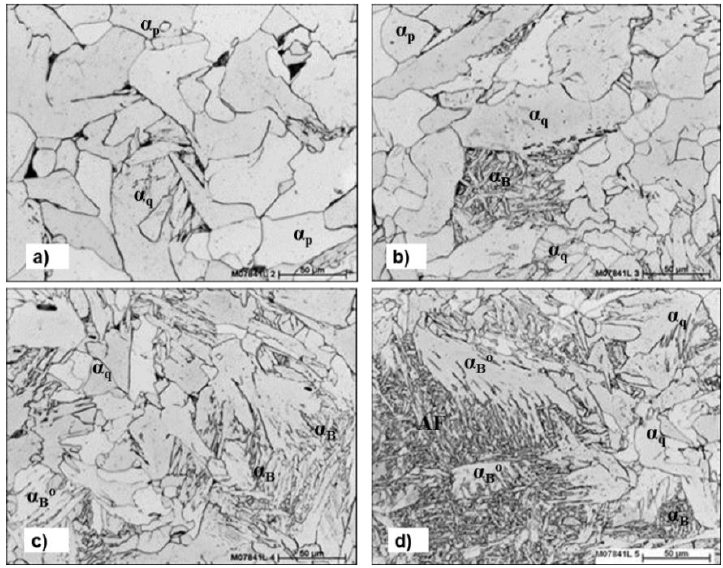
Figure 5. Optical microstructures for base UCS dilatometer samples cooled at ( a ) 3 °C/s, predominately α p with α q , ( b ) 10 °C/s, some α p , predominately α q , plus α B ( c ) 30 °C/s, ~α q + α B + α B ° and ( d ) 60 °C/s, ~α q + α B + α B ° +